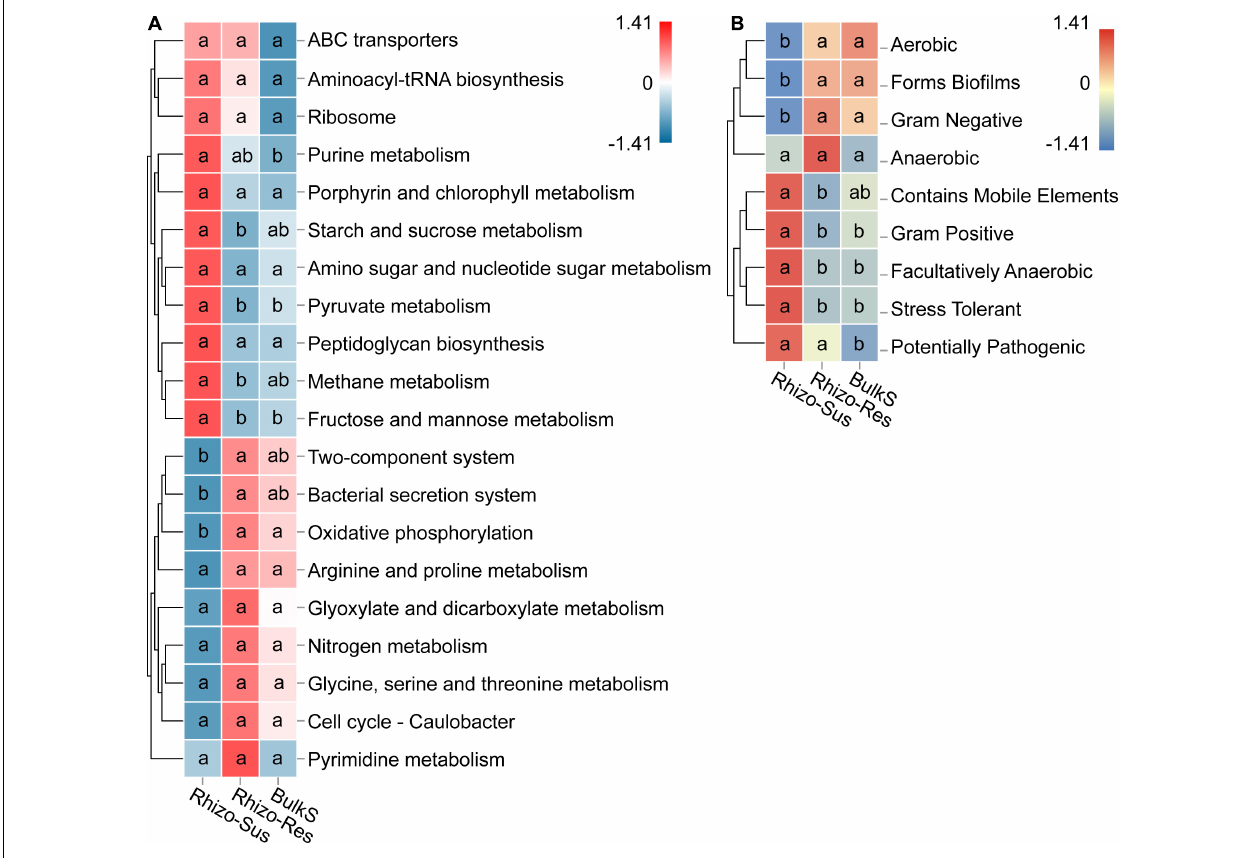
FIGURE 5 | Heatmap of main functions based on relative abundance of bacterial KEGG prediction (A) using Tax4Fun and phenotype (B) using BugBase in rhizosphere of C. oleifera (Rhizo-Sus) and C. yuhsienensis (Rhizo-Res) and bulk soil (BulkS) samples. The abundance of functions was normalized by Z-score method. The connecting lines on the left side describe the clustering of each function. The closer the color to red, the more dominant the function is. The lowercase in each row of heatmap indicated the significant differences among Rhizo-Sus, Rhizo-Res, and BulkS (conducted using Wilcoxon rank sum test, p < 0.05), N =